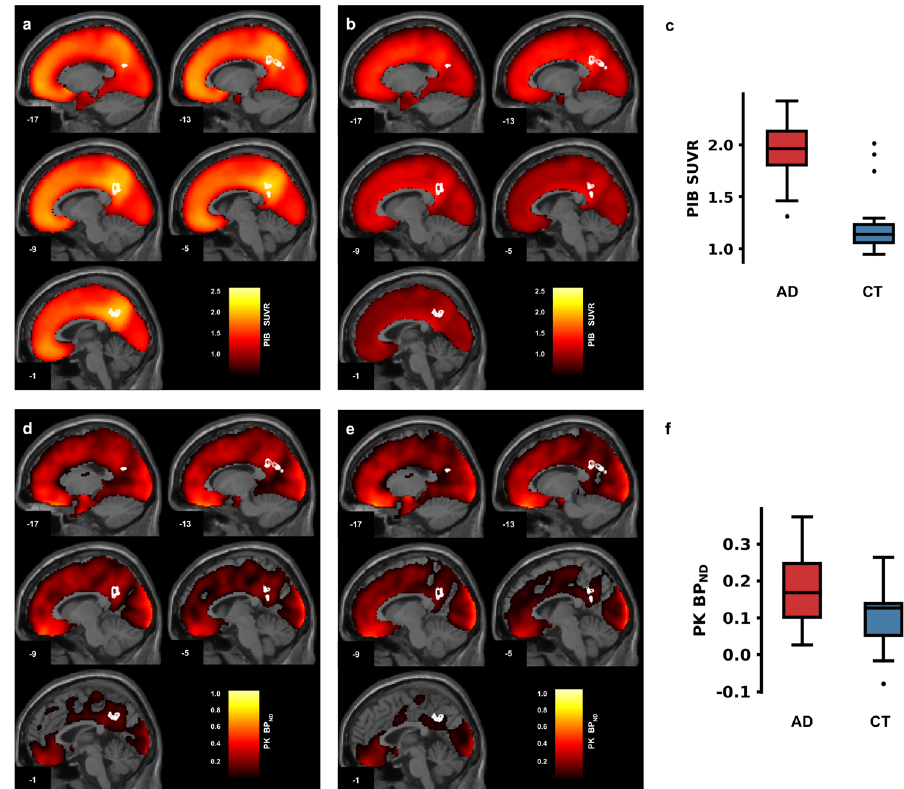
Fig. 2 A β deposition and extension of neuroin fl ammation maps across the cortex. The PCC cluster borders are highlighted in white. a Mean 11 C-PiB PET SUVR map of the AD group. b Mean 11 C-PiB PET SUVR map of the control group. c 11 C-PiB PET SUVR at PCC cluster in AD and control groups. d Mean 11 C-PK11195 PET BP 11 C-PK11195 PET BP 11 C-PK11195 PET BP ND map of the AD group. e Mean ND map of the control group. f ND at PCC cluster in AD and control groups. The sub fi gures ( c ) and ( f ) display the standard representation of a boxplot (median, fi rst and third quartile, non-outlier maximum and minimum, and the outliers - values that are more than 1.5 x IQR away from the top or bottom of the box, IQR: interquartile range). were taken from the FACES database 38 , faceless body images were taken from performing a total of six different categories of visual stimuli 37 . All images were grey-scale stimuli and were composed by three different subcategories - faces Bochum Emotional Stimulus Set database 39 , whereas images of hands and feet were category was composed by faces of young, middle age and old persons; the body selected from publicly available online images body shape silhouettes were created category showed body images, images of hands and feet and also body shape using a customized code in MATLAB R2014a (MathWorks, Natick, USA) ; images silhouettes; the objects category comprised tool, cars and chairs; the places category from the places ’ category were part of the database of the computational visual showed landscapes, buildings and skylines; the verbal stimuli comprised word, cognition laboratory 40 (http://cvcl.mit.edu/database.htm); stimuli from the objects ’ pseudowords and nonwords; and lastly scrambled category consisted of images category were taken from public online images; whereas verbal material was pro- with no semantic meaning. Stimuli were taken from different sources: face stimuli vided as a courtesy from the database of Universidade Católica Portuguesa, created